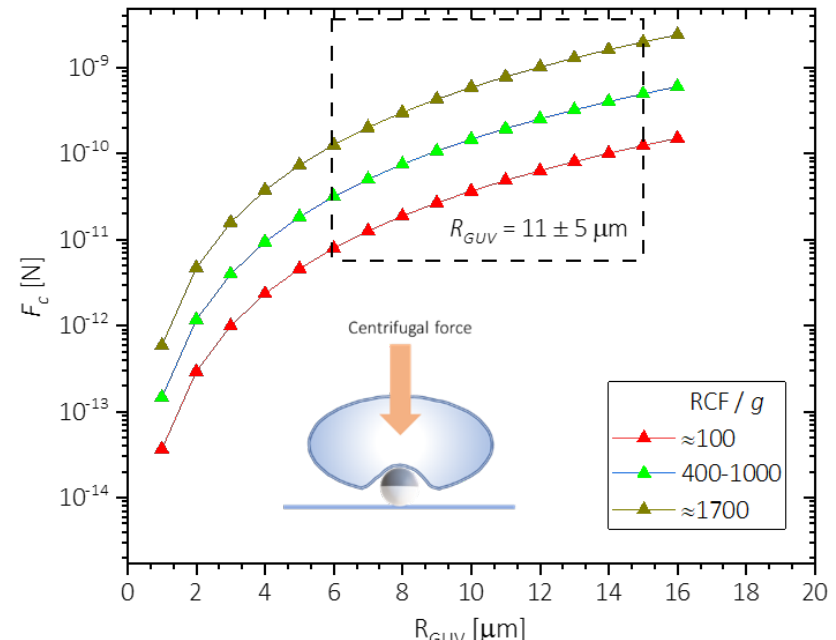
Figure 1. Schematic of force driven interaction between Janus colloids and GUVs by centrifugation. As the colloids were already sedimented to the bottom before adding the GUVs, the ∆ ρ RCF only acted on the vesicles. Calculated F centrifugation force F C = 4/3 π R 3 C GUV as a function of vesicle radius R GUV is shown in Figure 2 for three different levels of RCF corresponding to: low forces RCF / g ≈ 100, moderate forces 400 ≤ RCF / g ≤ 1000 and high forces RCF / g ≈ 1700. A window of the force experienced by the GUVs is shown in Figure 2, considering the GUV radius distribution ( R GUV = 11 ± 5 µ m) by gel formation method.